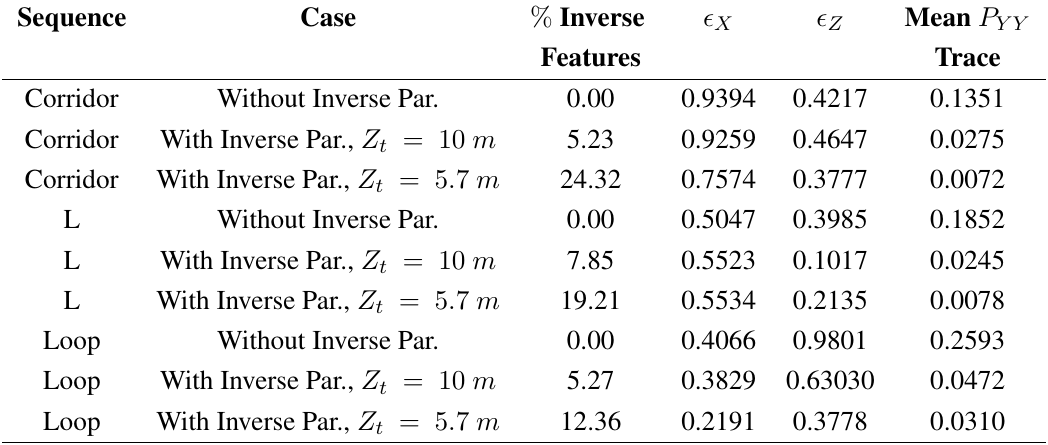
Table 2. Inverse depth and 3D comparison: absolute errors in trajectory and map